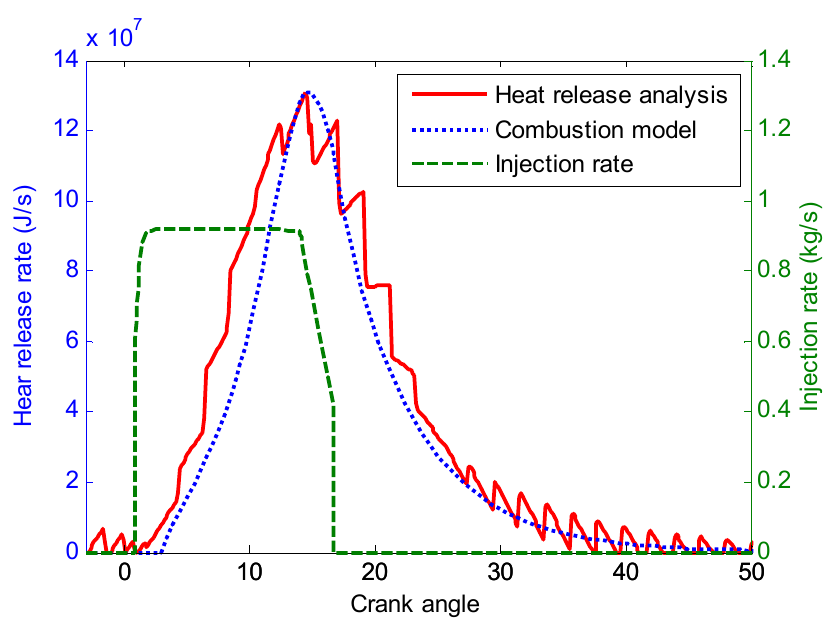
Figure 13. Heat release rate in case 2.